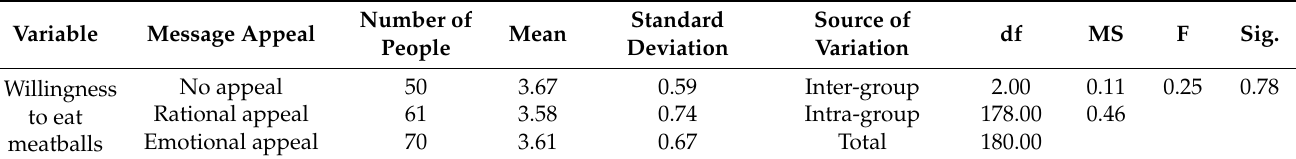
Table 2. Effect of message appeal type on foreigners’ willingness to eat meatballs ( n = 181).